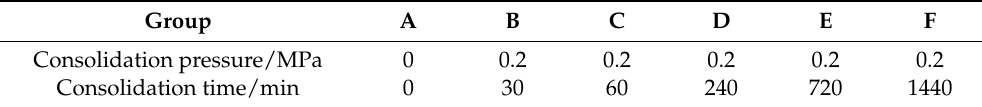
Table 2. Consolidation compression